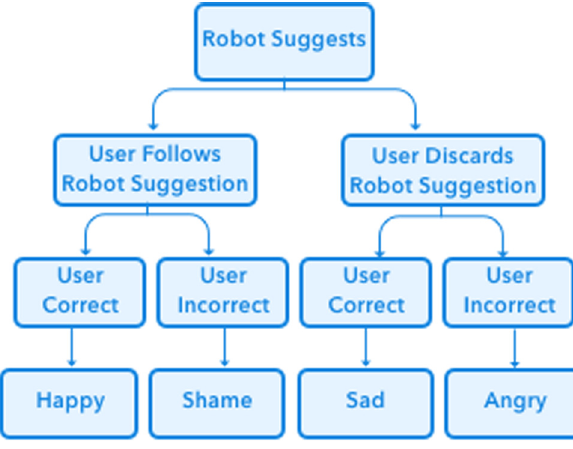
Figure 1: Robot Arm Emotional Response ( bottom row indicates robot response )